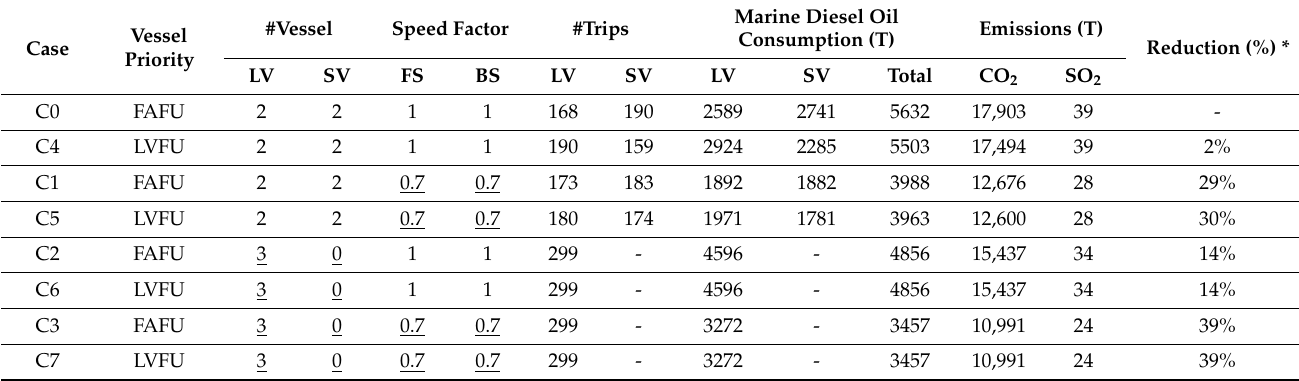
Table 8. Fuel consumption and GHG emissions.